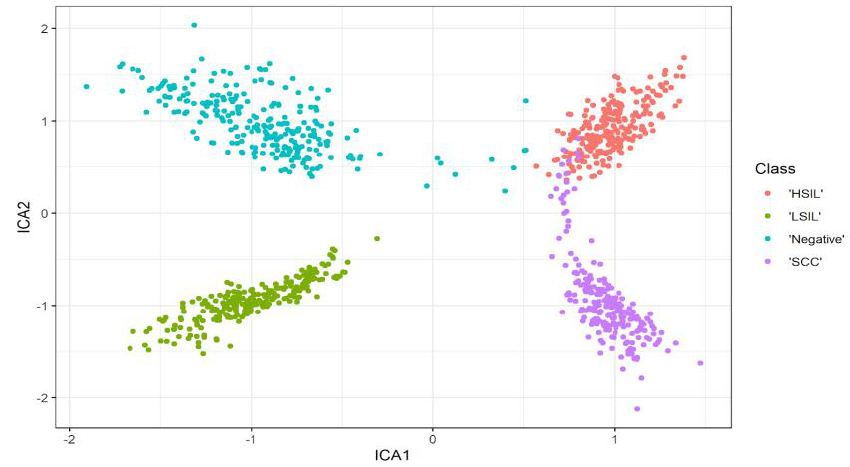
Figure 7. Scatter plot showing the first two independent components and how they discriminant between the four classes. The figure shows the effectiveness of separation between classes after se- lecting the most representative components using ICA.